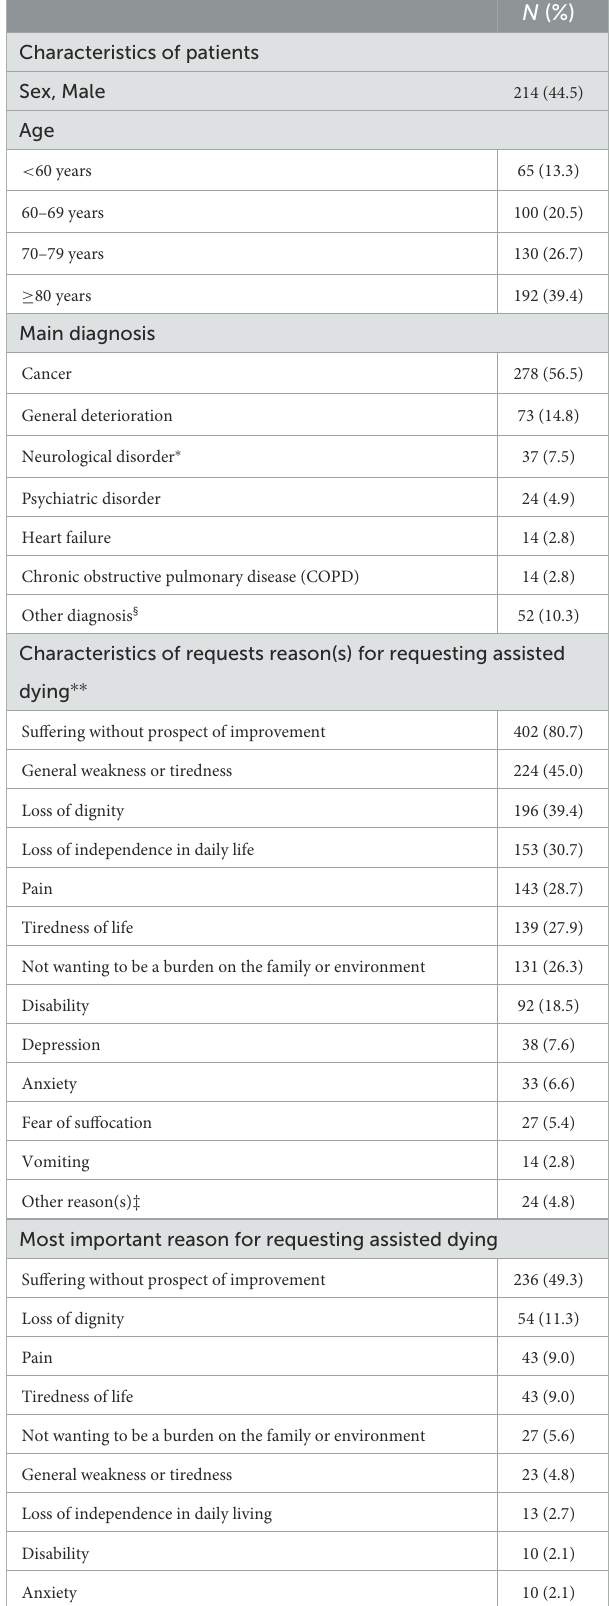
TABLE 1 Characteristics of attending physicians who held peer consultations for assisted dying request assessments with trained assisted dying (LEIF) consultants ( N = 502).